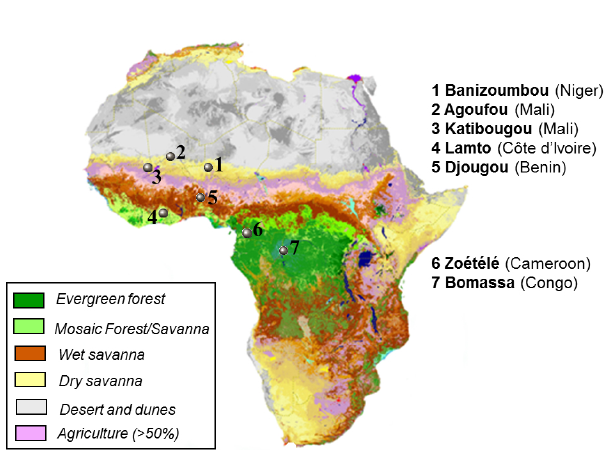
Fig. 1. Vegetation and location map of the seven measurement sta- tions of the IDAF network. Only the seven IDAF stations of west and central Africa included in the present study are